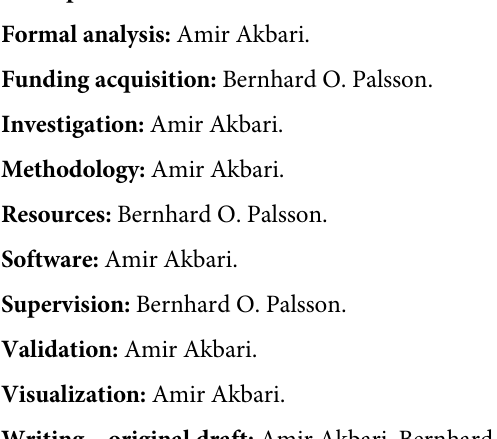
S3 Table. Forth-order finite-difference schemes to approximate the second derivative of a function f ð ^ r Þ on the grid shown in S1 Fig. Expressions in the Scheme column are derivatives evaluated at ^ r , where f 00 Þ . Note that D ^ r ≔ D ^ r ≔ f 00 ð ^ r j j j + 1 � j � N (see S1 N c